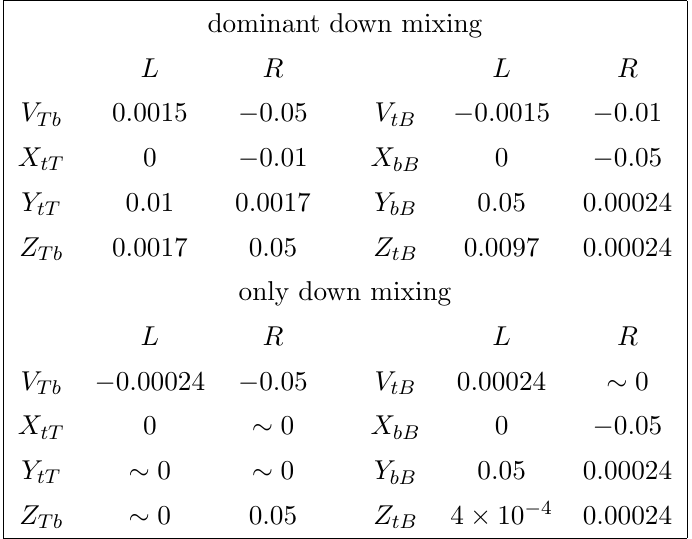
Table 3 . Top: couplings for the down-mixing scenario with s u (for which s u = 0 : 0086, s d L s d = 0 : L